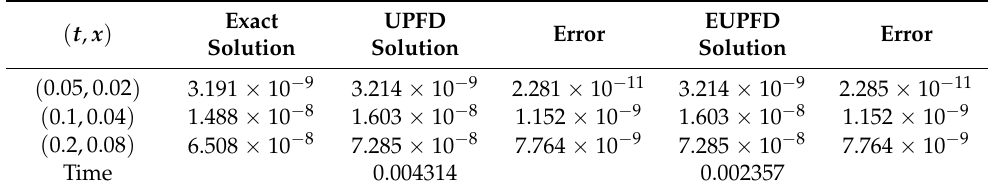
Table 7. Numerical results of the nonlinear ADR equation at a fixed ∆ x = 0.01, ∆ t = 0.025, r = 0.05 and D =